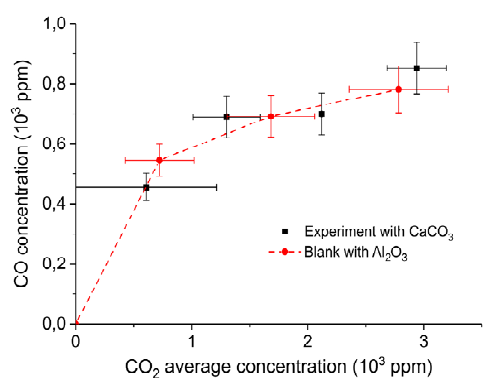
Figure 10. CO outlet concentration vs. CO 2 average concentration obtained in a packed bed of 10 mg CaCO 3 and 90 mg Al 2 O 3 at 630 °C with different CO 2 concentrations in Ar and a flow rate of 90 mL/min (squares); all results interpolated to 1.5 W plasma power. The same experiment was also performed with 100 mg Al 2 O 3 only (circles). Error margins of the CO concentration are provided, as well as the window of the CO 2 concentrations (note these are not error margins).